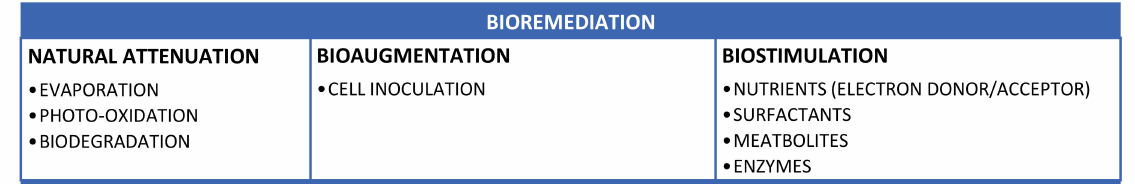
Figure 8. Different types of bioremediation